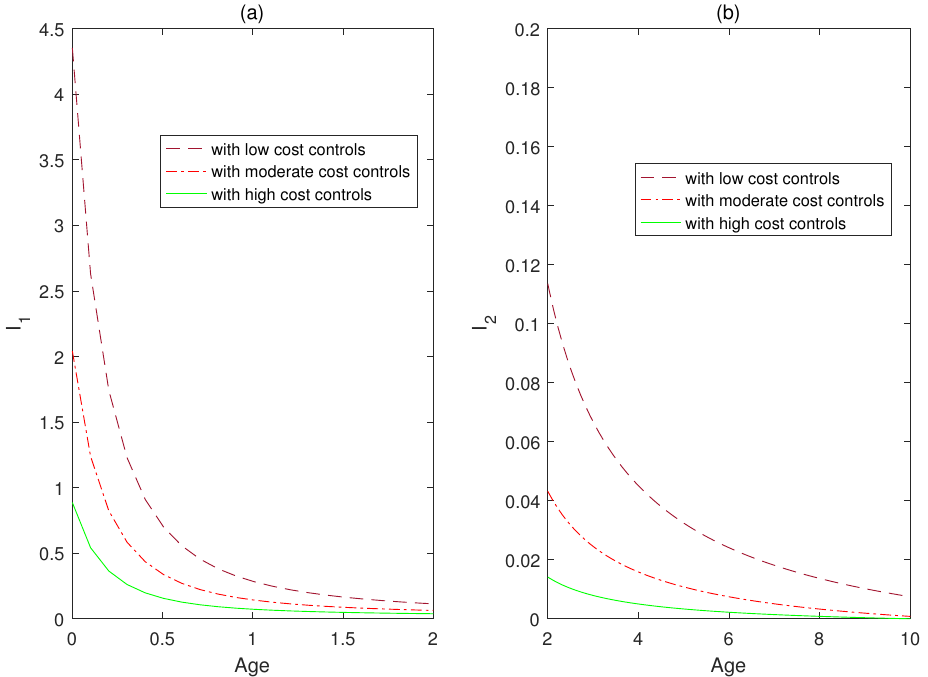
Figure 6. The weight parameter values with respect to disease infection and cumulative number of media coverage are set as γ 11 = 3.5, γ 13 = 5, and three scenarios are as follows, (i) low optimal cost controls: γ 12 = γ 21 = γ 22 = 0.35; (ii) moderate optimal cost controls: γ 12 = γ 21 = γ 22 = 3.5; (iii) high optimal cost controls: γ 12 = γ 21 = γ 22 = 35. ( a ) The total number of infected individuals with respect to age at the acute stage. ( b ) The total number of infected individuals with respect to age at the chronic